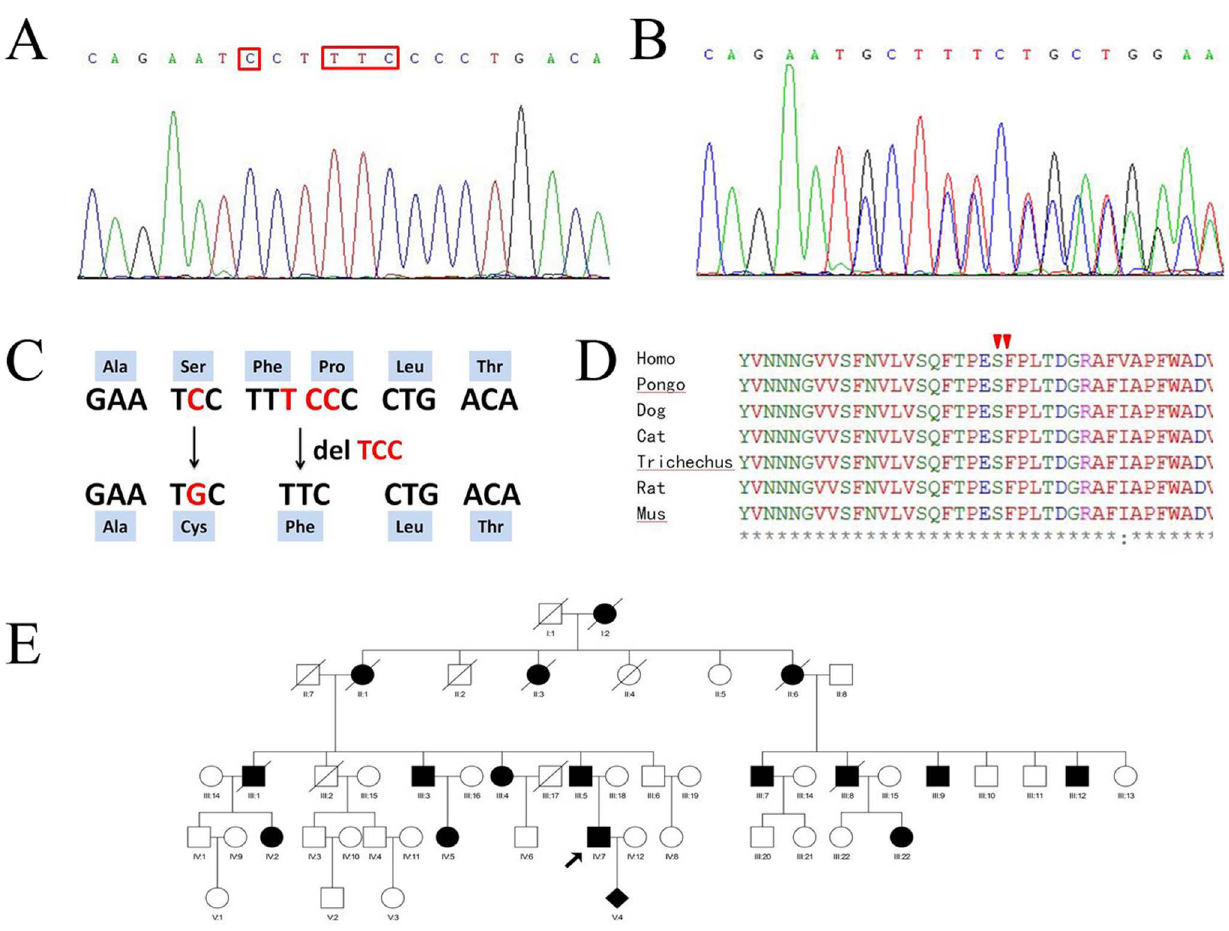
Figure 1. The c.257–262CCTTTC . GCT mutation detected in Family 3187. ( A ) Partial DNA sequences of the TECTA gene in a normal family member and ( B ) the c.257–262CCTTTC . GCT mutation (in family members IV:2, IV:7, III:4, III:5, III:3, IV:5). ( C ) The amino acid changes caused by the changes in the DNA sequence. ( D ) Alignment of the a -tectorin and homologous sequences in the N-terminal ENT-like interdomain. The arrow marks the position of the c.257–262CCTTTC . GCT mutation (p. Ser86Cys; p. Pro88del). The ENT-like domain is highly conserved in different species. ( E ) The pedigree of Family 3187 for the c.257–262CCTTTC . GCT mutation. The solid symbols indicate affected individuals.